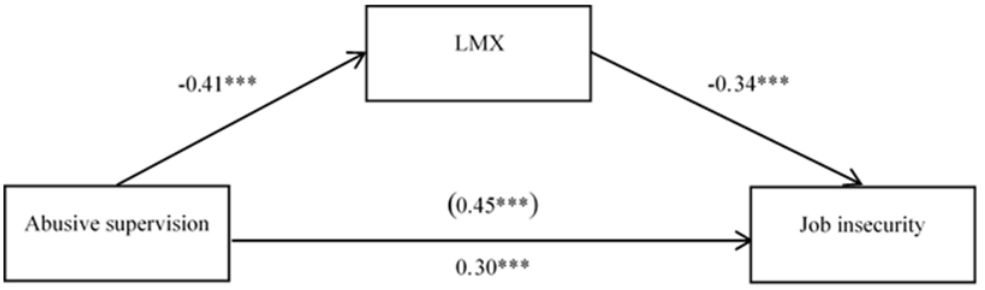
Figure 1. The mediating role of LMX in the relationship between abusive supervision and job insecurity. *** p <